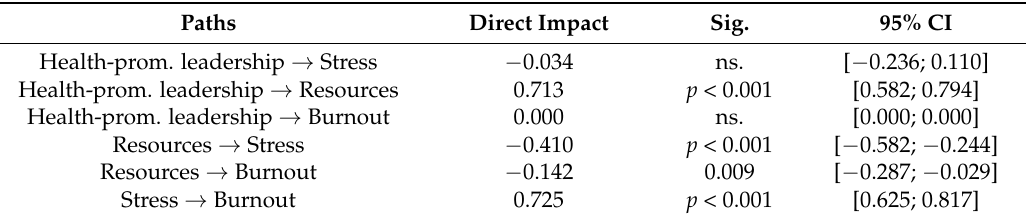
Table 5. Direct impacts in the structural model—sample 2.